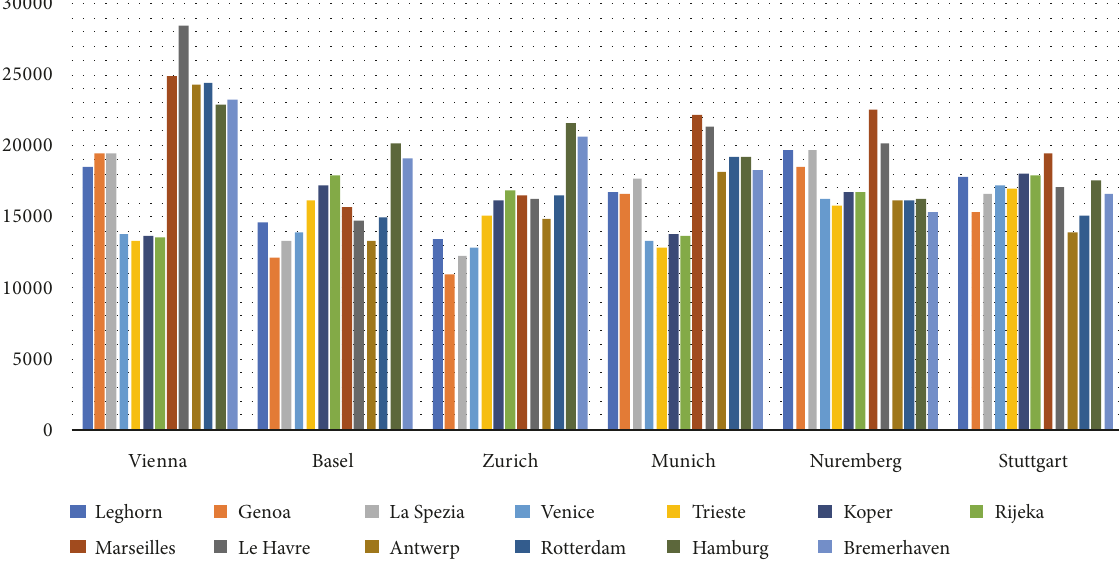
Figure 7: Monetary costs for a full train (€) from the ports considered in the analysis, towards Central-Southern European destinations. Optimisation by monetary costs.